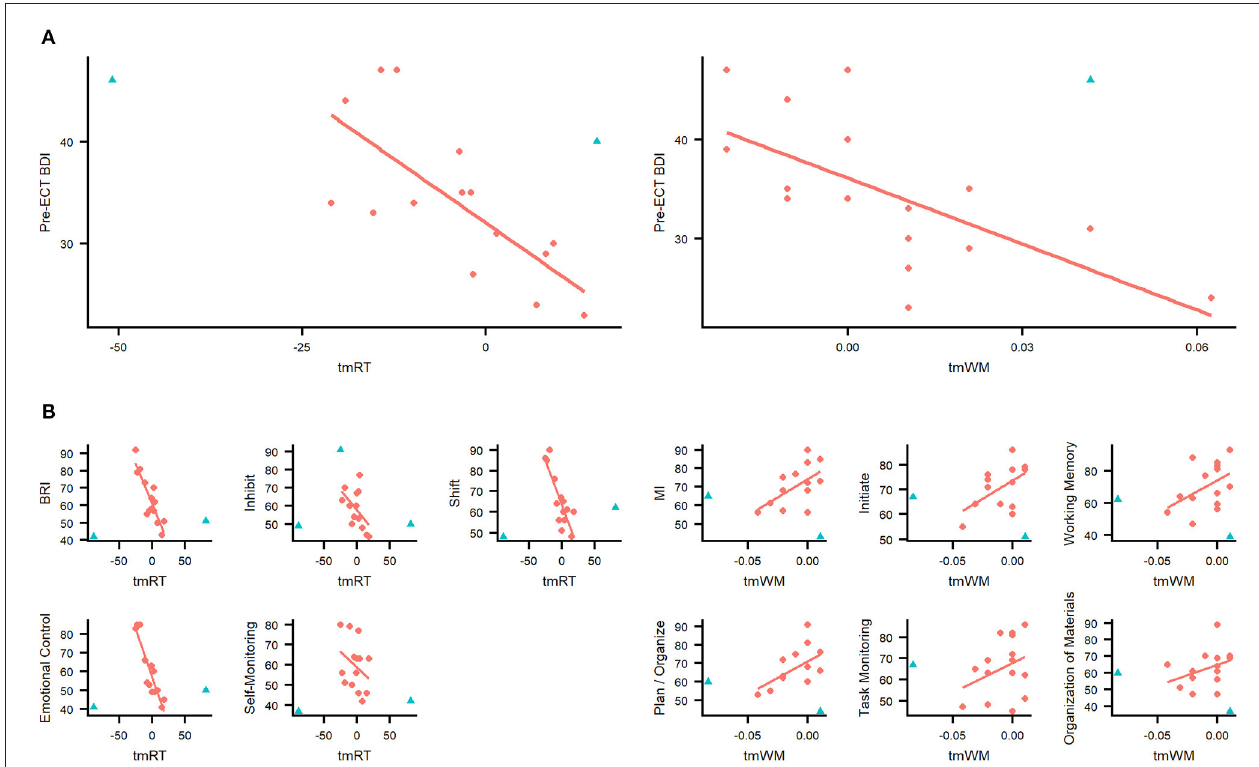
FIGURE 4 | (A) Novel threat modulation indices reflect depression severity pre-ECT. Pre-ECT threat modulation index correlations with Beck Depression Inventory (BDI) score for incorrect responses (tmWM) and reaction time (tmRT). Both indices correlated significantly (Spearman correlation) with BDI score pre-ECT. (B) Novel threat modulation indices reflect executive functioning and emotion regulation in daily life post-ECT. Post-ECT threat modulation index correlations with Behavior Rating Inventory of Executive Function—Adult version (BRIEF-A) scales and indices. tmRT correlated significantly with BRI index and Inhibit, Shift, Emotional control and Self-monitoring scales. All of these scales are part of the BRI index. tmWM correlated with the MI scale and Initiate, Working memory, Plan and organize, and Self-monitoring scales. All of these scales are part of the MI index. Red dot, subjects included in correlation analysis; blue triangle, subject is an outlier and excluded from correlation analysis. Outliers were identified using Cook’s and Mahalanobis